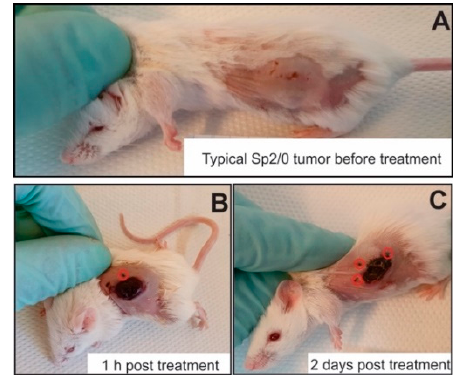
Figure 4. Representative photographs of mice before ( A ) and after 1 h ( B ) and 2 days ( C ) post treatment (3.5 kV/cm × 800 ns × 250 pulses with doxorubicin). The red circles ( B , C ) represent visible electrode injection points.